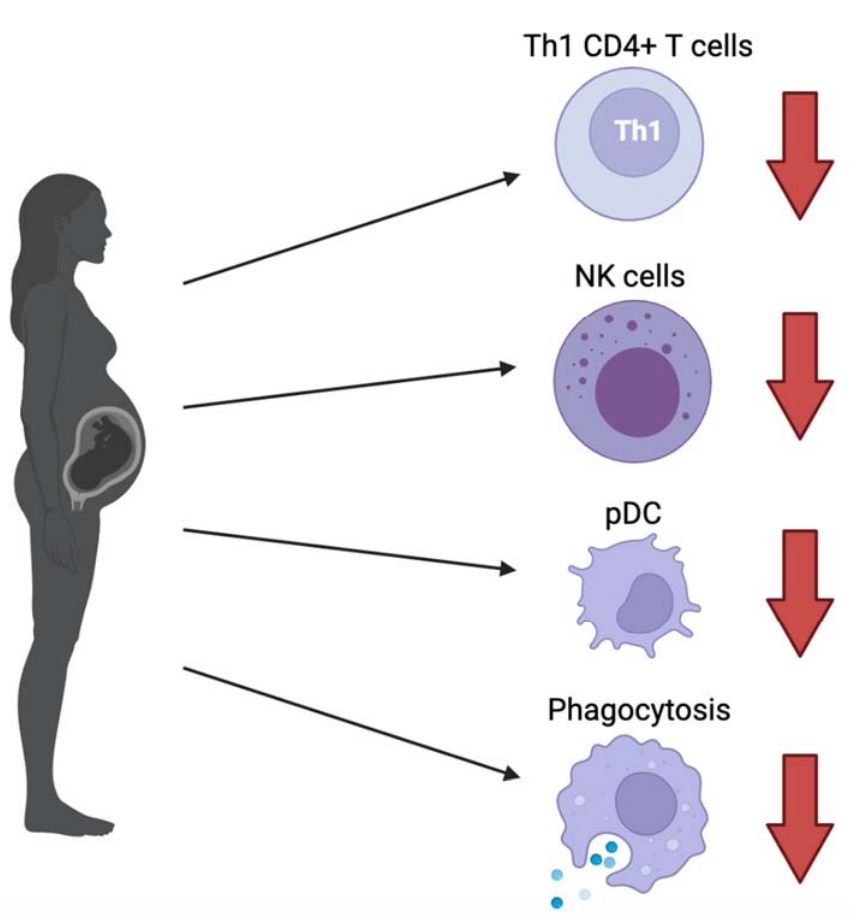
Figure 1. General attenuation of various components of the immune system in pregnancy, leading to increased susceptibility to SARS-CoV-2 and decreased efficacy of viral clearance. These include a shift from Th1 to Th2 CD4+ T cells, decreased natural killer (NK) cells, plasmacytoid dendritic cells (pDC) producing type 1 interferons, and the phagocytic index of neutrophil granulocytes and monocytes. In addition to these specific changes, increased progesterone in the maternal circulation further dampens immune response.